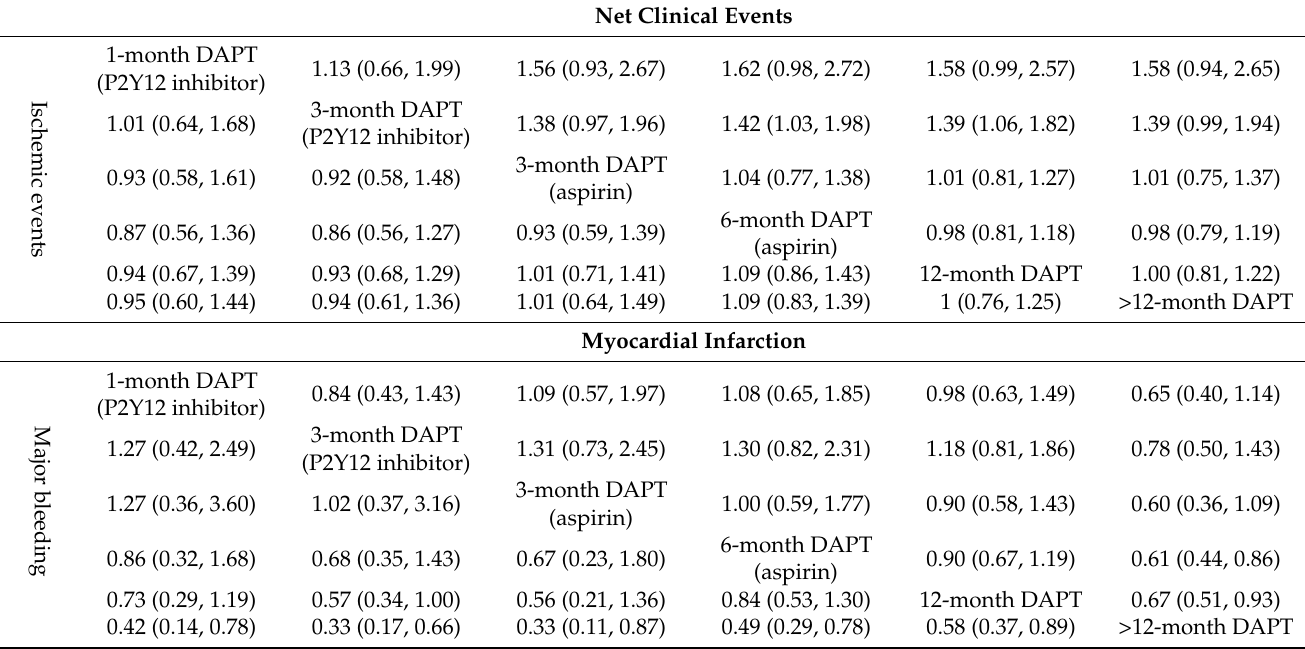
Table 1. Comparisons for Primary Outcomes of All DAPT Strategies.